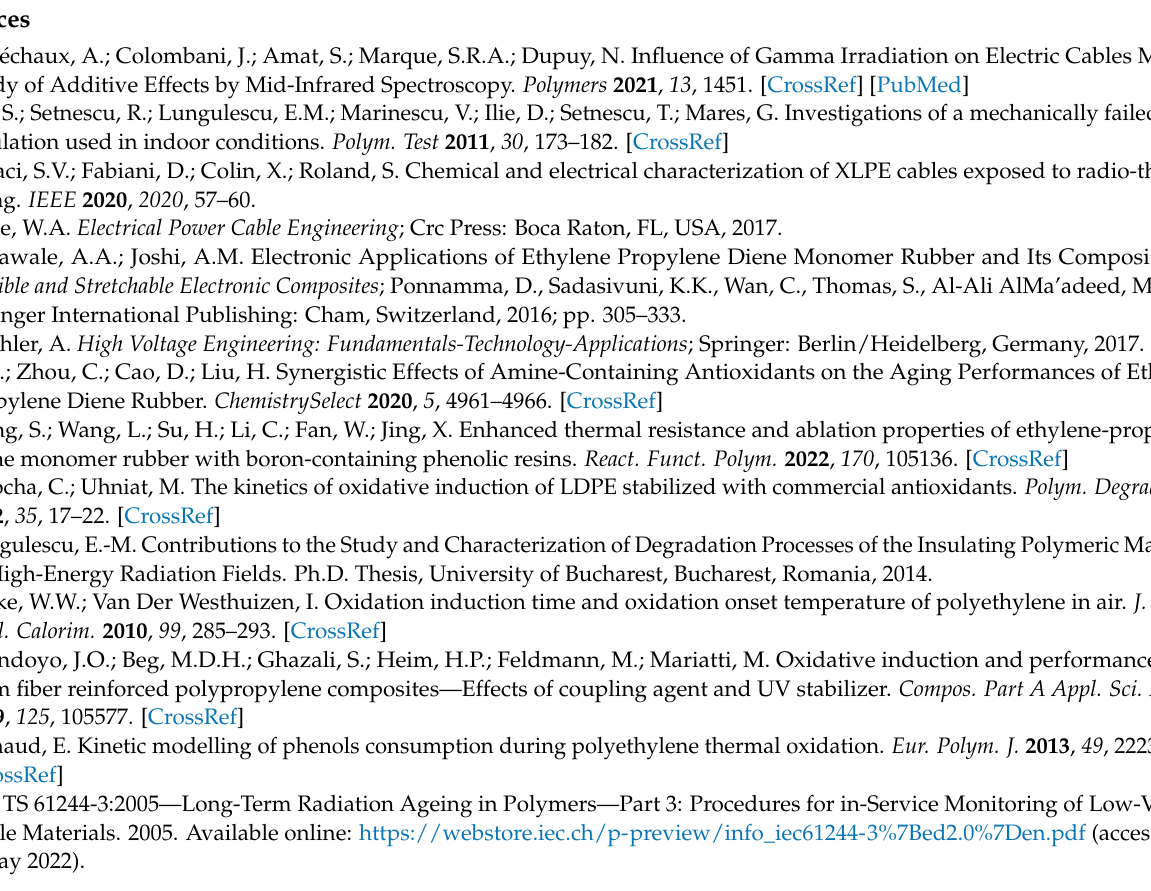
Figure S5: Structure of IC1 cable (General purpose, I&C—Instrumentation and Control- cable); Figure S6: Structure of C2 cable (General purpose, HV, coaxial cable); Figure S7: Structure of